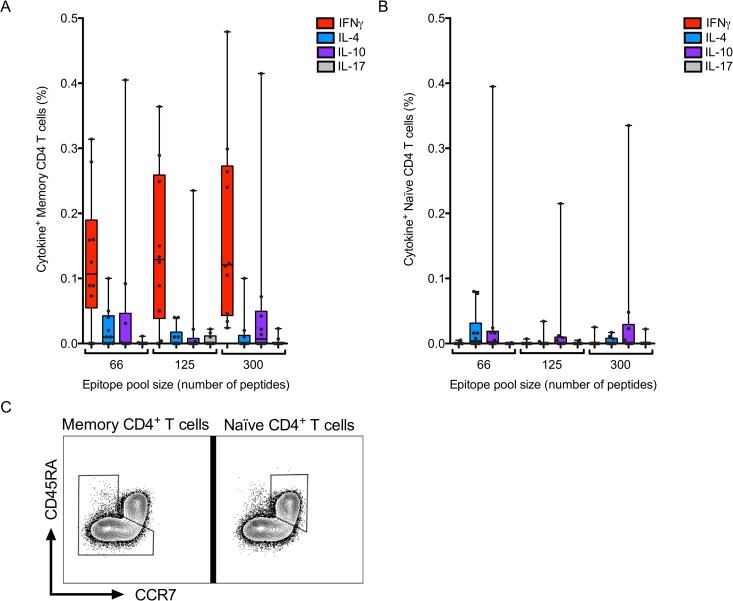
Epitope pool responses are highly polarized towards IFNγ production.Frequencies of cytokine-expressing CD3+CD4+ memory T cells (A) or CD3+CD4+ naïve T cells (B) in response to the pool of 66, 125 and 300 epitopes. Each dot represents one donor, median ± interquartile range is indicated. (C) Gating strategy for memory versus naïve CD4 T cells. Plots are gated on total CD3+CD4+ T cells.